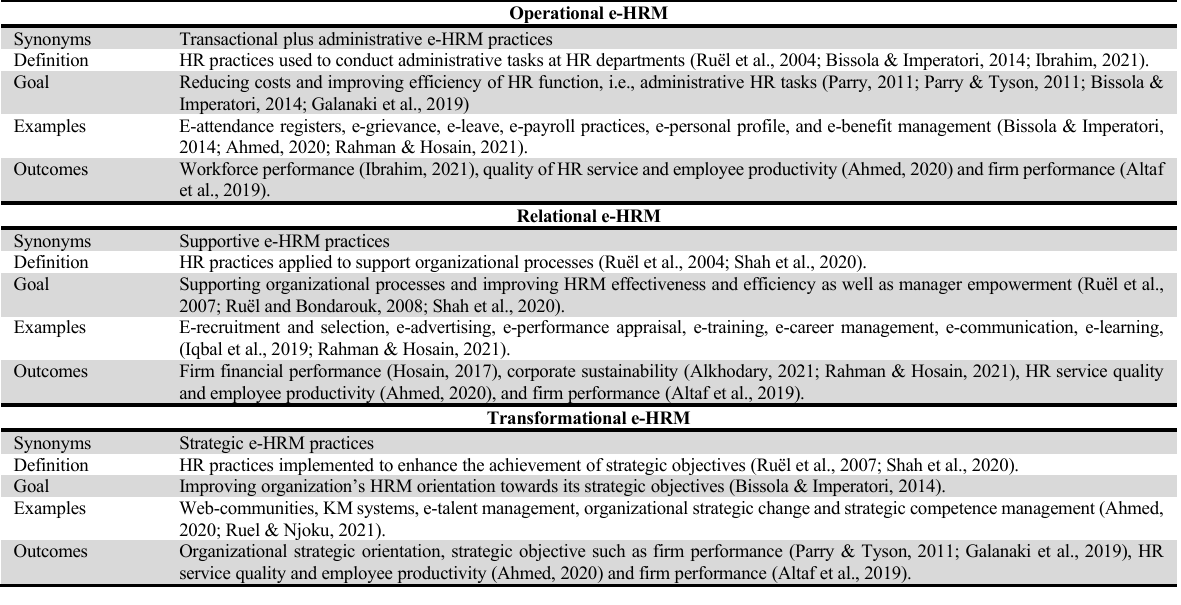
Summary of operational, relational, and transformational forms of e-HRM